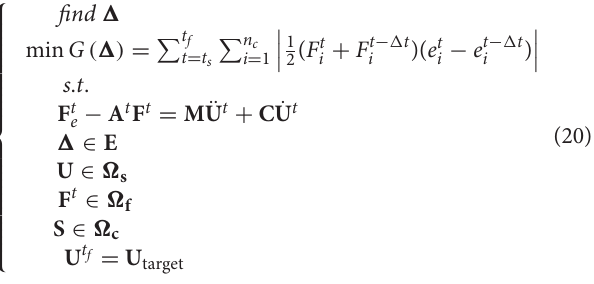
FIGURE 3 | Total rest length change vs.